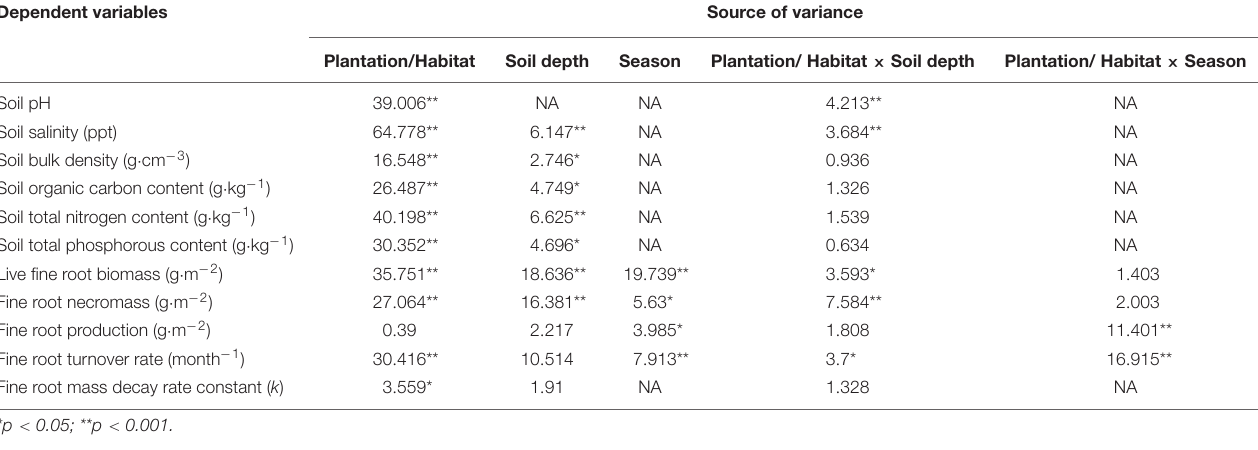
TABLE 1 | F values of two-way ANOVA testing the differences in fine root dynamics and soil variables among different mangrove species/ habitats and soil depth in Hanjiang River Estuary, south China. Dependent variables Source of variance Plantation/Habitat Soil depth Season Plantation/ Habitat × Soil depth Plantation/ Habitat ×